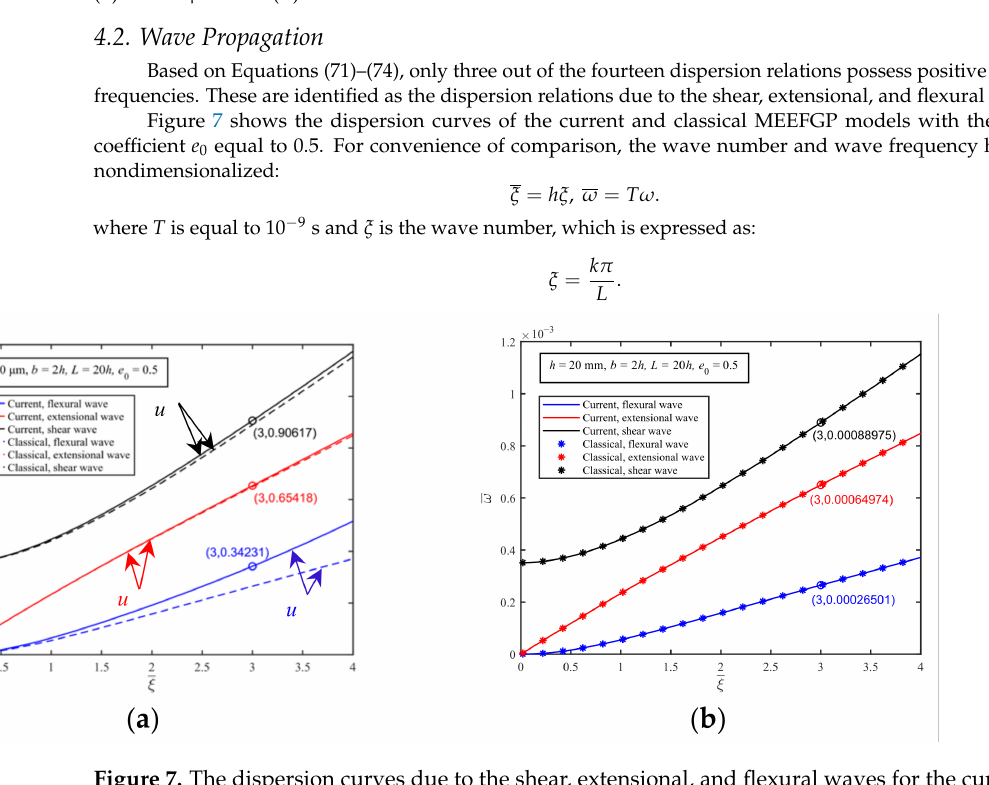
Figure 6. Maximum deflections of the MEEFGP microbeam for different porosity coefficients with ( a ) h = 20 µ m and ( b ) h = 20 mm.